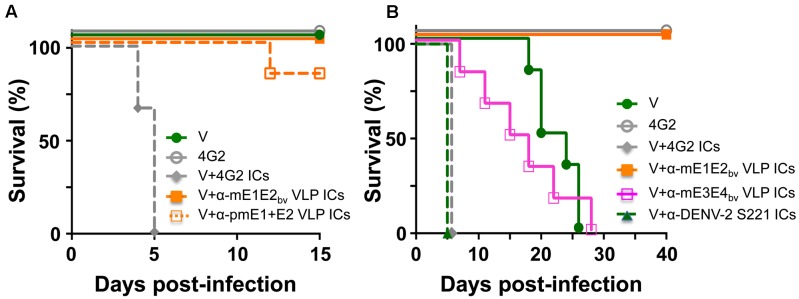
Evaluation of the ADE potential of DENV E-based VLP vaccine-induced antibodies. (A) Groups (n = 6) of AG129 mice were challenged with a sub-lethal dose of DENV-2 S221 (V) or 100% in vitro-neutralized ICs of DENV-2 S221 with mAb 4G2 (V+4G2 ICs), anti-mE1E2bv VLP antiserum (V+α-mE1E2bv VLP ICs) or anti-pmE1+E2 antiserum (V+α-pmE1+E2 VLP ICs) and monitored for survival. One set of mice was inoculated with mAb 4G2 alone (4G2) in the absence of any virus as a survival control. (B) Experiment similar to that in (A), performed for extended time duration. Groups (n = 6) of AG129 mice were challenged with a sub-lethal dose of DENV-2 S221 (V) or 100% in vitro-neutralized ICs of DENV-2 S221 with mAb 4G2 (V+4G2 ICs), anti-mE1E2bv VLP antiserum (V+α-mE1E2bv VLP ICs), anti-mE3E4bv VLP antiserum (V+α-mE3E4bv VLP ICs), or anti-DENV-2 S221 antiserum (V+ α-DENV-2 S221 ICs), obtained from V group in (A). A ‘4G2’ group was included as survival control group as in (A). Survival curves of different groups at 100% have been slightly displaced, to avoid superimposition, to make them visible.